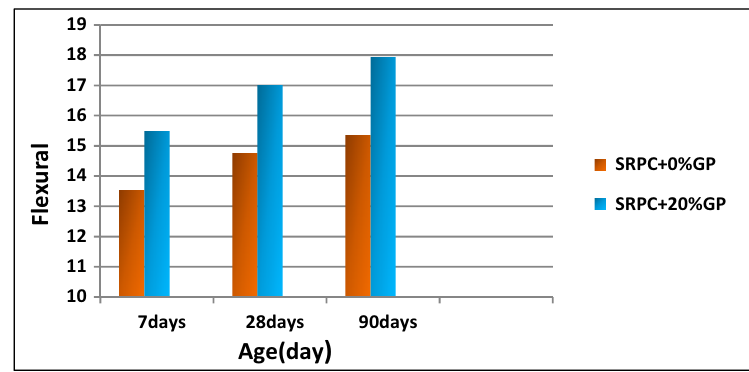
Figure 6: Relationship between the fl exural strength ( MPa ) and age ( day ) for SRPC.